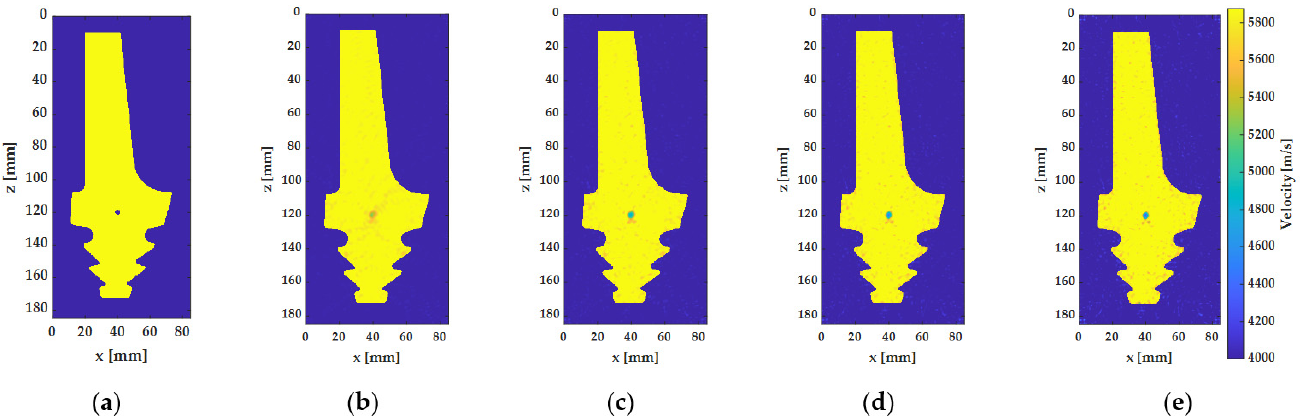
Figure 8. ( a ) True model with a 3 mm circular hole and tomographs with different iterations: ( b ) k = 5; ( c ) k = 10; ( d ) k = 20; ( e ) k = 40.